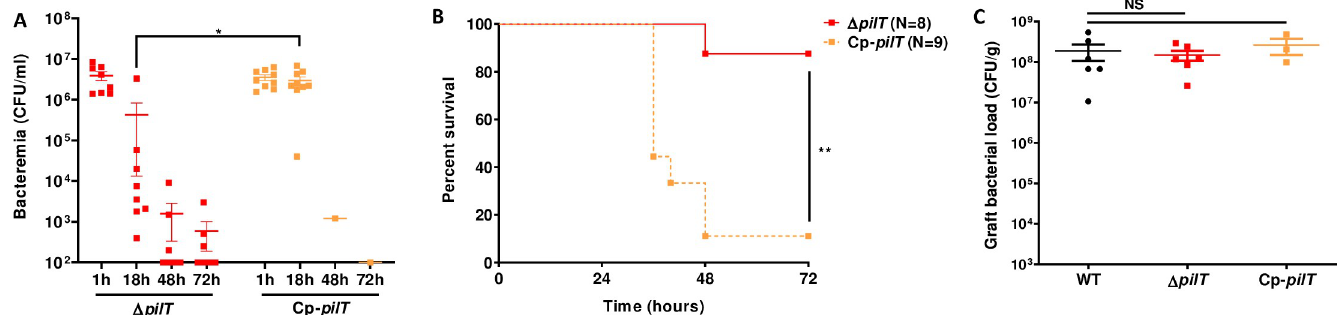
Fig 2. Pilus-retraction is required to establish sustained bacteremia and lethality. (A) Grafted mice were infected IV with 5x10 6 CFU of N . meningitidis , Δ pilT mutant and its complemented Cp- pilT strain. Bacteremia of mice was measured at 1, 18, 48 and 72 h PI by culturing serial dilutions of blood samples on agar plates. Two independent experiments, n = 8 or 9 mice per group. Bars represent mean ± SEM, � p < 0.05, one-way ANOVA followed by multiple comparison test. (B) Kaplan- Meier plot showing the survival of infected grafted mice shown in panel A. Mice survival was assessed each day during 72 h. Two independent experiments, �� p < 0.01, two-sided log-rank Mantel-Cox analysis. (C) Grafted mice were infected IV with 5x10 6 CFU of WT N . meningitidis , isogenic Δ pilT mutant, or complemented strain Cp- pilT . Graft bacterial load at 18 hours PI was measured by quantitative culture on agar plates. Two independent experiments for WT and Δ pilT strains and one experiment for complemented Cp- pilT strain, n = 3 or 6 mice per group. Bars represent mean ± SEM, NS p > 0.05, one-way ANOVA followed by multiple comparison test.